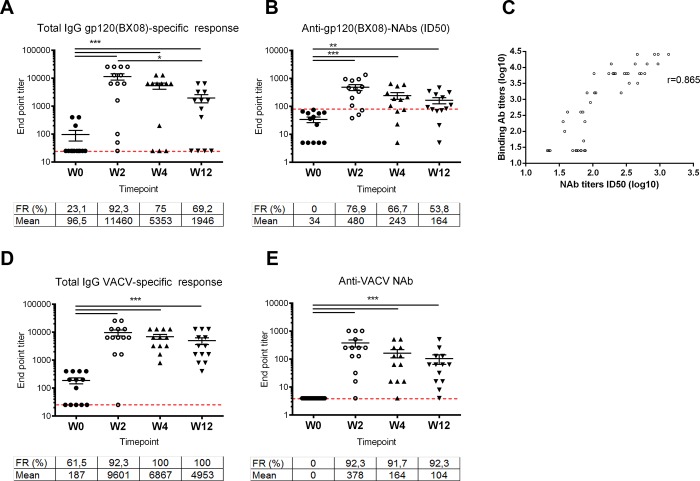
Humoral responses.A: Total IgG binding antibody titers against HIV-1 gp120 (BX08). B: BX08 neutralization ID50 titers. C: Correlation between BX08 binding IgG and neutralizing ID50 titers. D: Total IgG binding titers against VACV proteins. E: VACV neutralization ID50 titers. The frequency of responders and the mean titers at the different time points are shown in each graph. Dashed line represents the threshold considered as positive response. Statistical differences were evaluated by one way ANOVA test (using the linear model log10(y) ~ x_patient + x_week + epsilon) followed by Tukey's honest significant difference criterion. *p<0.05, **p<0.01, *** p<0.005 (***4). Pearson’s correlation coefficient (r value) was calculated between BX08 binding IgG and neutralizing ID50 titers.